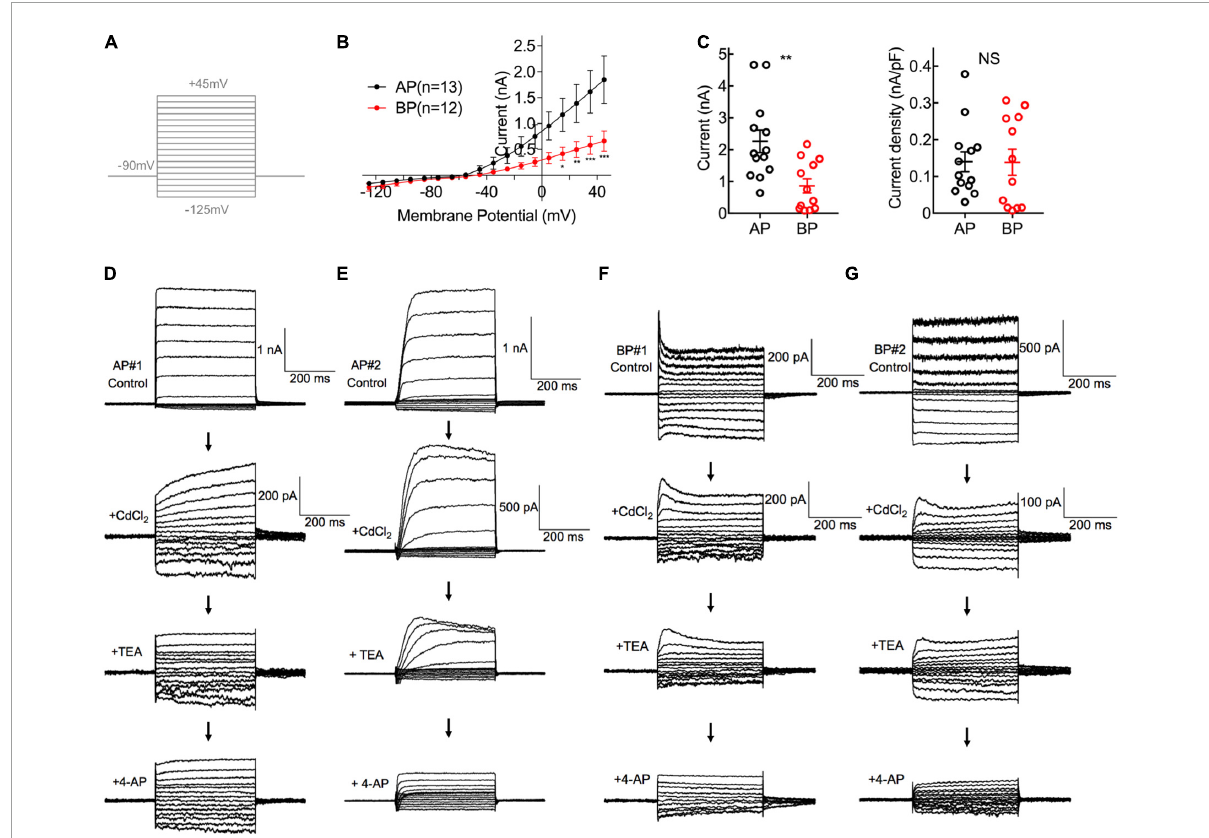
FIGURE2 Comparisons of K + Current in AP and BP hair cells. (A) The voltage-clamp protocol used in potassium current recordings. Activation of K + currents was elicited by a series of 100-ms depolarizing voltage steps (command potentials between –125 and + 45 mV, in 10 mV increments) from a holding potential of –90 mV. (B) Corresponding I–V curves are plotted for whole-cell potassium currents at the different test potentials from medial AP (black) and BP (red) hair cells. AP hair cells showed a notably larger amplitude of total outward current than that of BP. (C) The left panel showed the peak potassium current at the potential of + 45 mV in medial AP and BP hair cells ( n = 13 and 12; unpaired Student’s t -test, ** p < 0.01). The right panel showed no significant difference in the density of potassium current. (D–G) A different protocol with voltage steps ranging from –125 to + 5 mV, from a holding potential of –65 mV, was used in pharmacological experiments to dissect different types of potassium currents. Displayed are the diversity of representative potassium currents recorded from two medial AP (D,E) hair cells and two BP (F,G) hair cells, by the successive application of three blockers, 2 mM CdCl 2 , 10 mM tetraethylammonium (TEA), and 1 mM 4-AP. (D) Here shows a representative cell of the majority (20/23) tested medial AP hair cells, which exhibited a slowly non-inactivating, delayed rectifying outward current (top panel) with increasing hyperpolarization, accompanied by a non-inactivating inward rectifying potassium current ( I K ( IR ) ) that has been identified in saccular hair cells. Note that 10 mM TEA can reduce the component of non-inactivating outward current. (E) Displayed is one of the minority (3/23) hair cells recorded from medial AP hair cells, which shows a fast inactivating component in outward current and it can be blocked by applying 4-AP. (F,G) Typical traces of potassium current from BP hair cells, which depicted low sensitivity to TEA and high sensitivity to